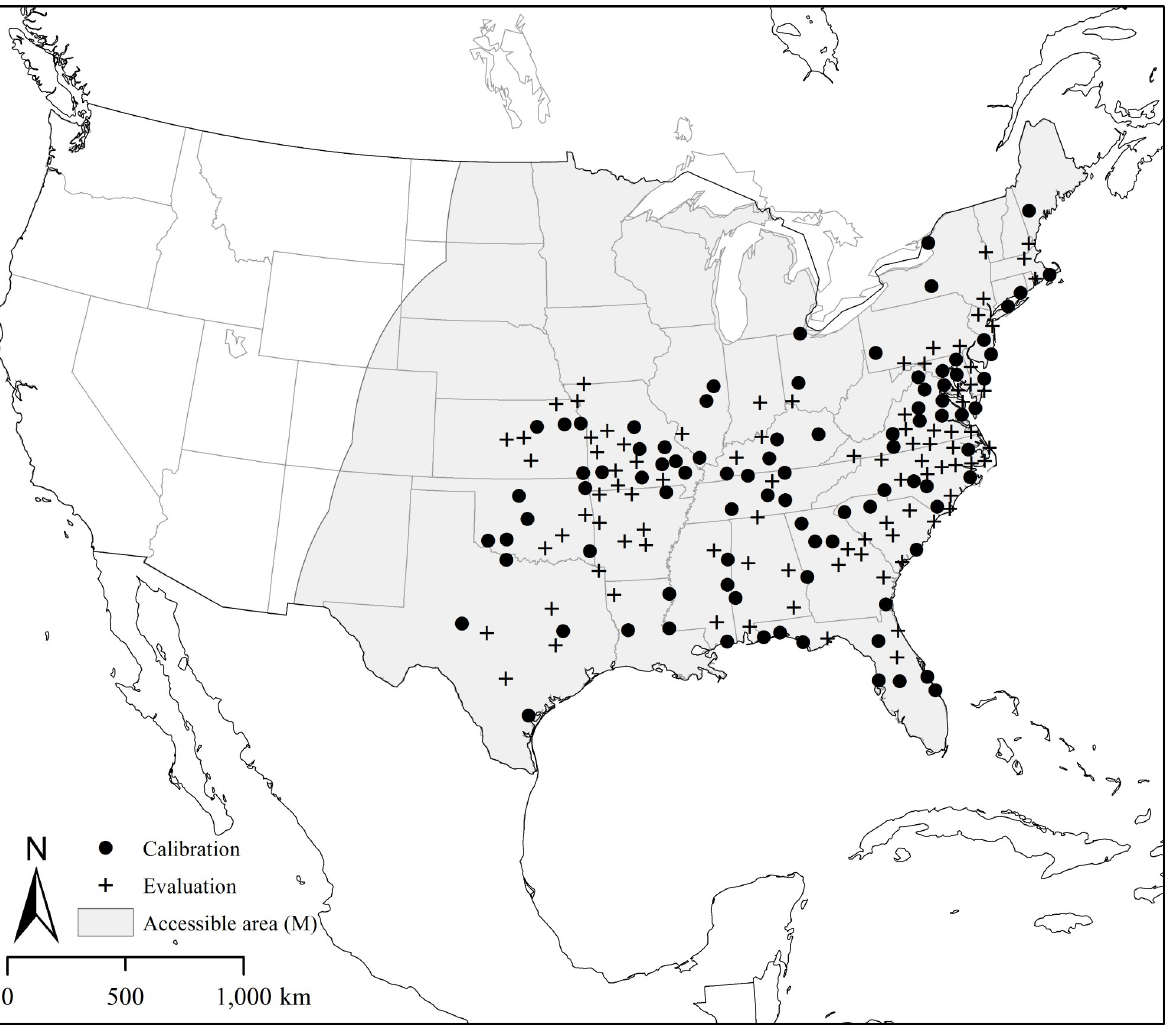
Fig 1. Geographic coordinates representing collection locations of Amblyomma americanum and accessible area (M) used in the construction of ecological niche models.